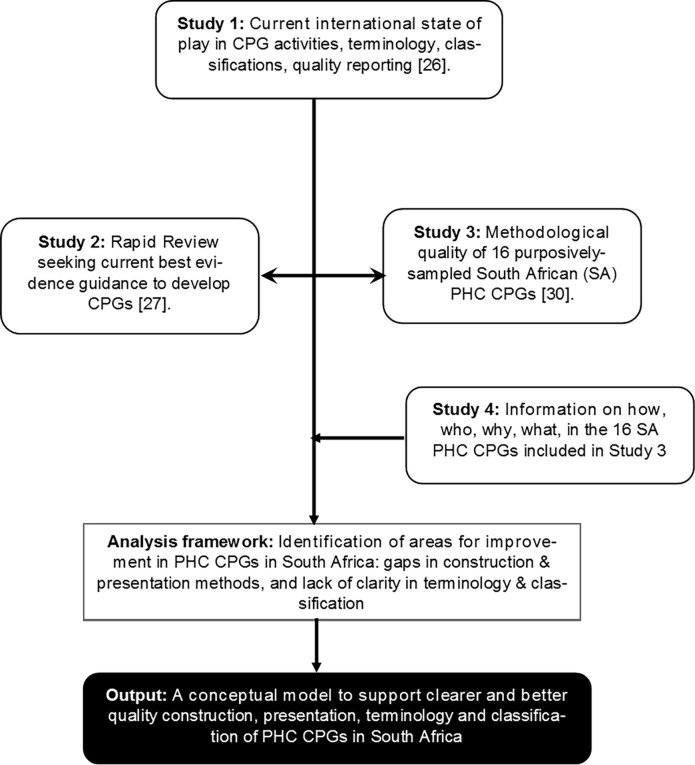
Case study approach.